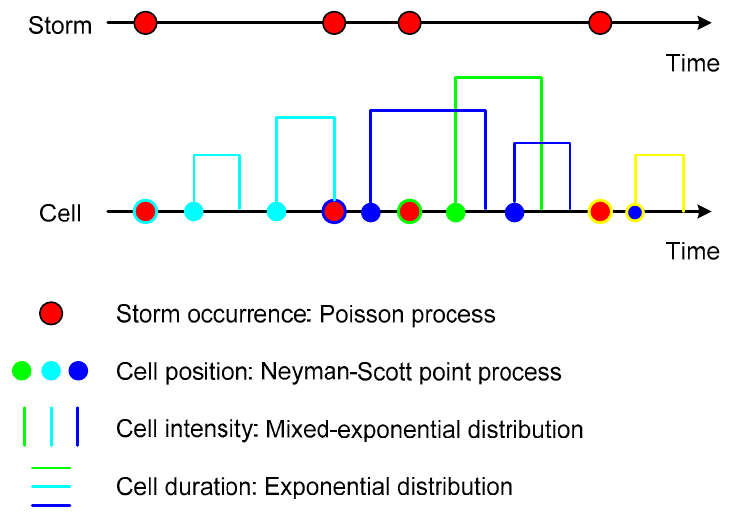
Figure 4. A Schematic depiction of the NSRPM.